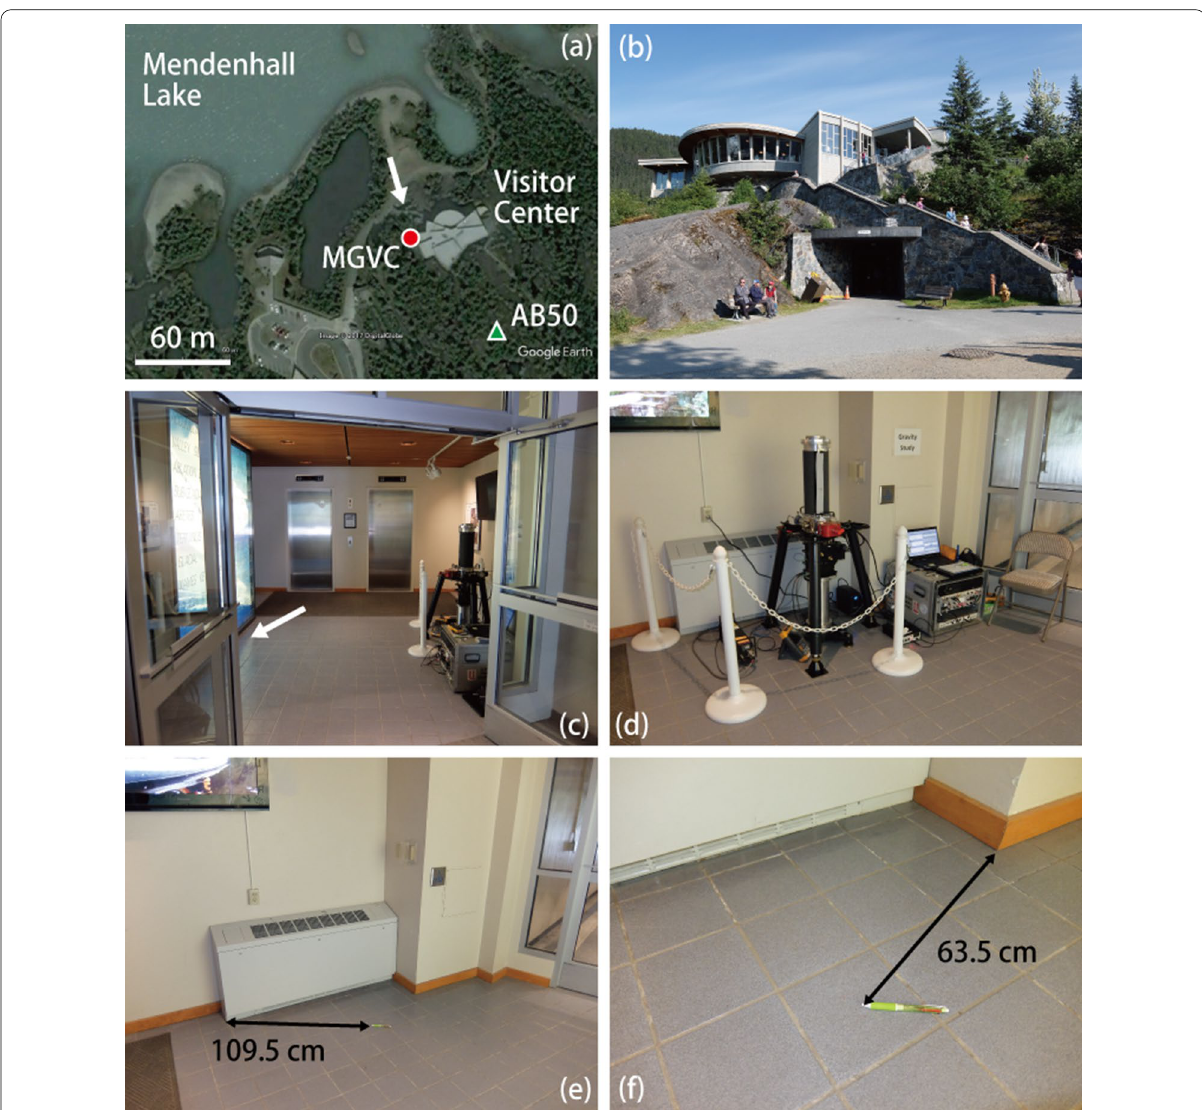
Fig. 14 Location of the MGVC gravity point. a The satellite image of Mendenhall Glacier Visitor Center derived from Google Earth Pro. The red circle and green triangle indicate the MGVC gravity point and AB50 GNSS station, respectively. The white arrow indicates the direction of the photo ( b ). b The entrance of Mendenhall Glacier Visitor Center. MGVC is located about 25 m from the entrance. c The elevator lobby of the Mendenhall Glacier Visitor Center, where the AG point is located. The new AG point is located on the right side of the lobby when facing the elevators. The old AG point (Sun et al. 2010) was located at the left side of the lobby. However, in June 2012, we found that the old point was not available because of the illuminating exhibition. The white arrow indicates the photo direction of Figure A5 in Sun et al. (2010). d The FG5-111 absolute gravimeter on the new AG point. e The position of the new AG point. It is located at the tip of the pen and approximately 109.5 cm from the corner of the heater. The heater should not be activated during the AG measurement, because its vibration magnifies the scatter of the AG data. f The exact position of the new AG point. It is located at the center of a tile and approximately 63.5 cm from the corner of the pillar. Note that we failed to measure the gravity difference between two AG points using a relative gravimeter directly during the campaign AG measurement in 2012, due to the exhibit installed on the old point by the visitor center. Instead, we considered the gravity difference by adding a term of the step-like gravity change between 2008 and 2012 in reproducing the temporal gravity change at MGVC (Fig.